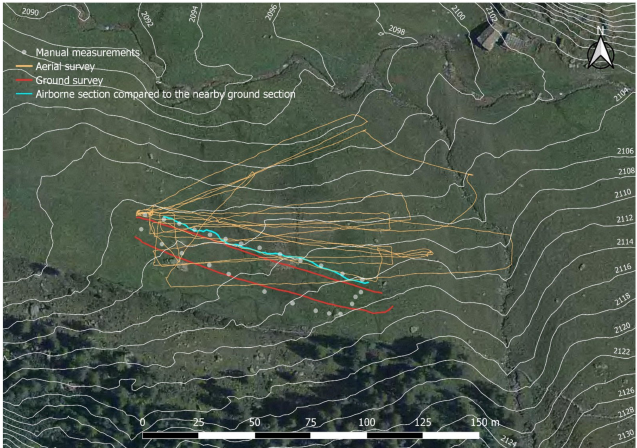
Figure 3. Cheneil survey map: aerial survey, ground survey, manual measurements. The blue line refers to the aerial section compared, in the results section, to the nearby ground-based section. Contour lines every 2 m. Map rendering with QGIS [32]. Base map: 2012 Ortophoto by Aosta Valley regional service geoCartoSCT.